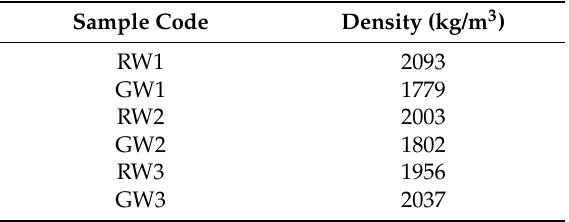
Table 4. The apparent density of each prepared